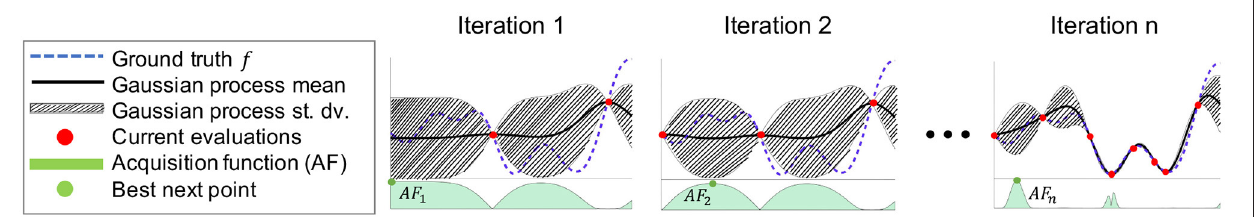
FIGURE 1 | Summary of single objective Bayesian optimization. Reproduced with permission from Parsa et al. (2019a).